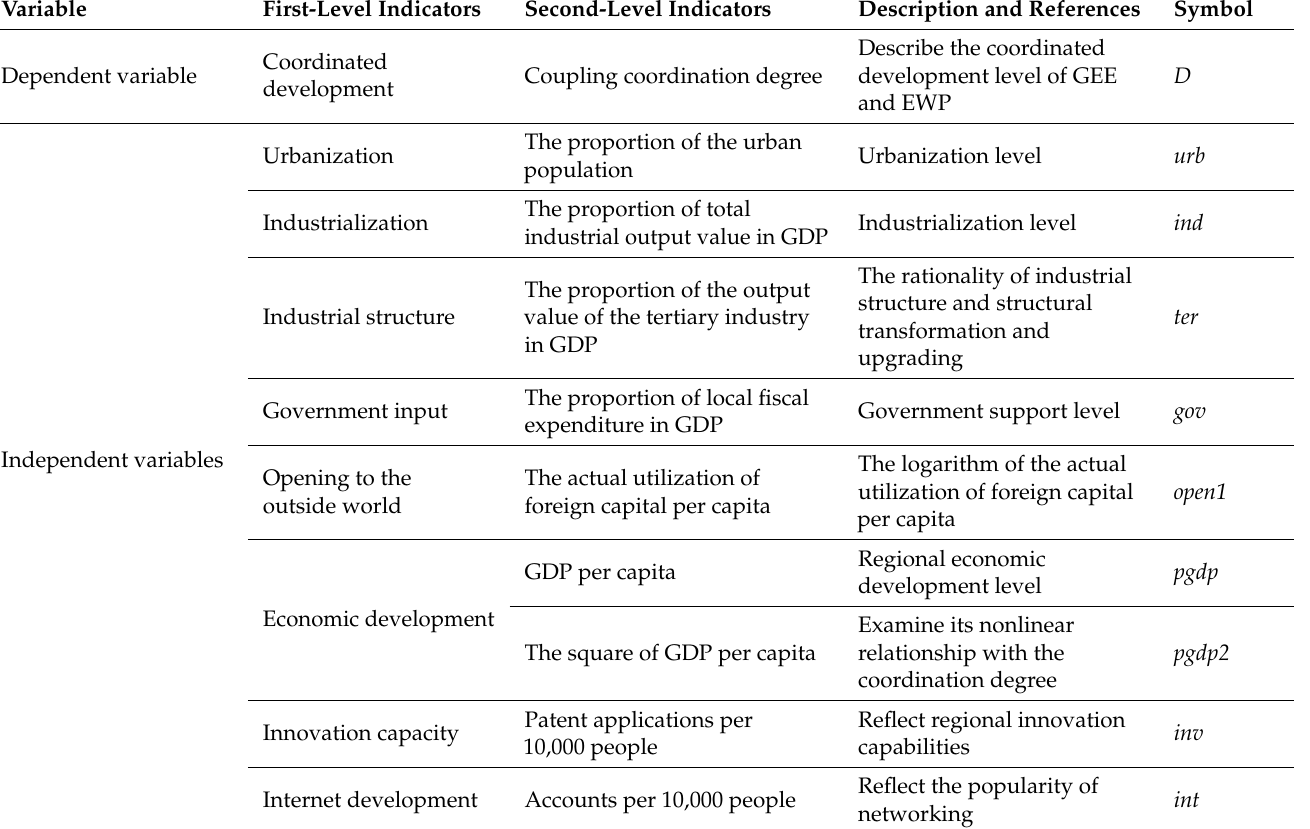
Table 5. Variables for the influencing factors of coupling coordination